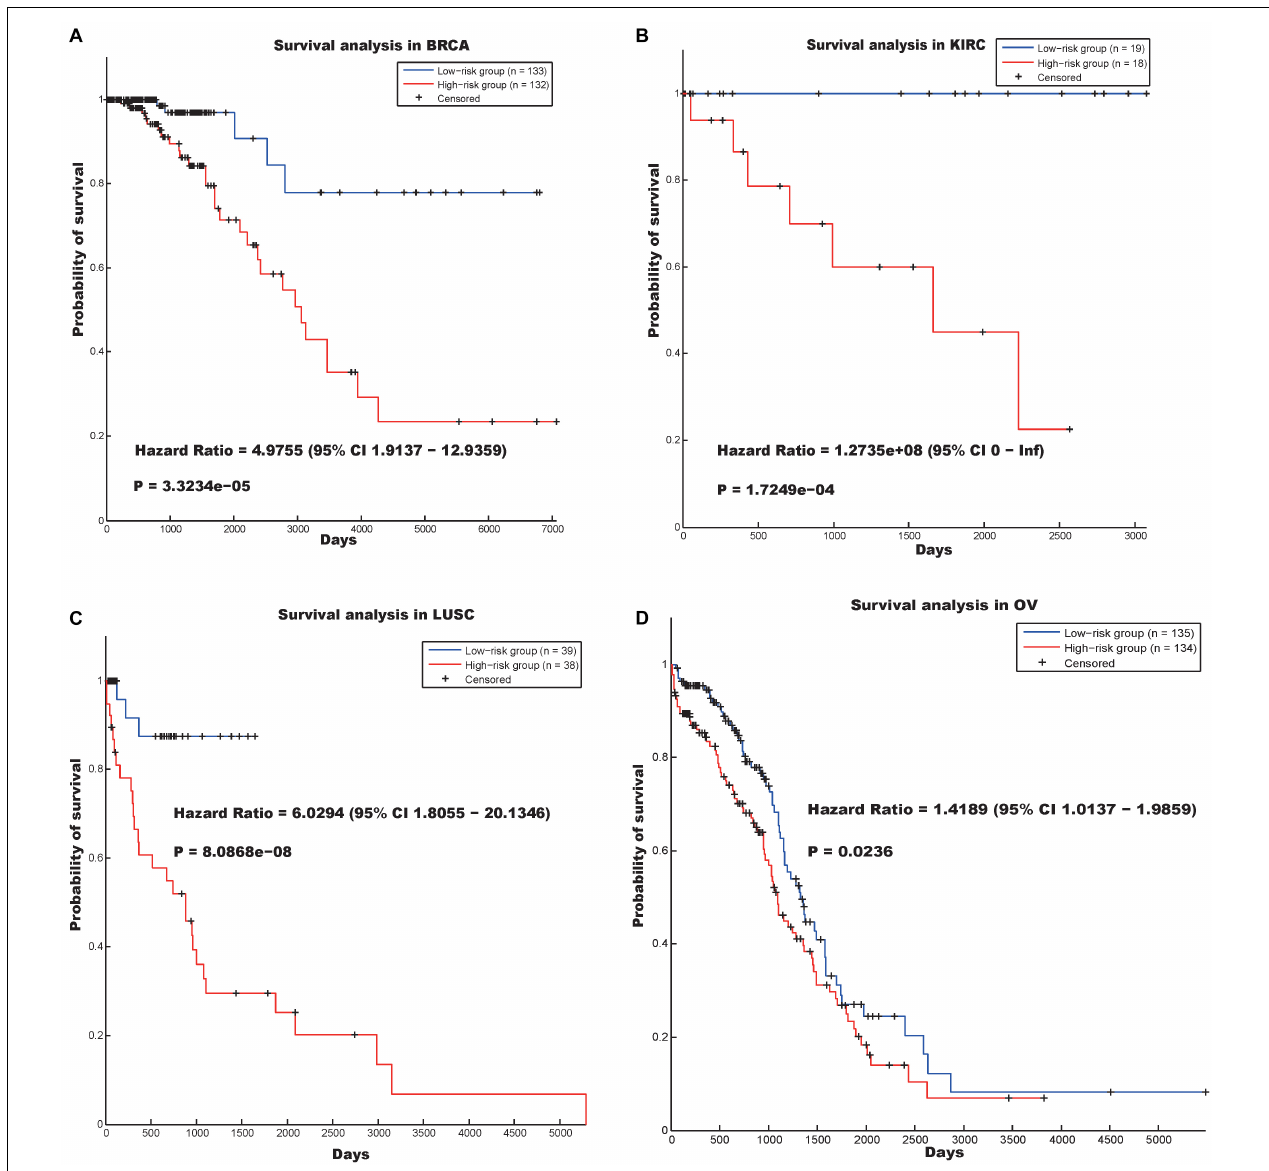
FIGURE 2 | Survival analysis using the hallmark “Mitotic cell cycle” in four cancer data sets. (A) BRCA, (B) KIRC, (C) LUSC, and (D)